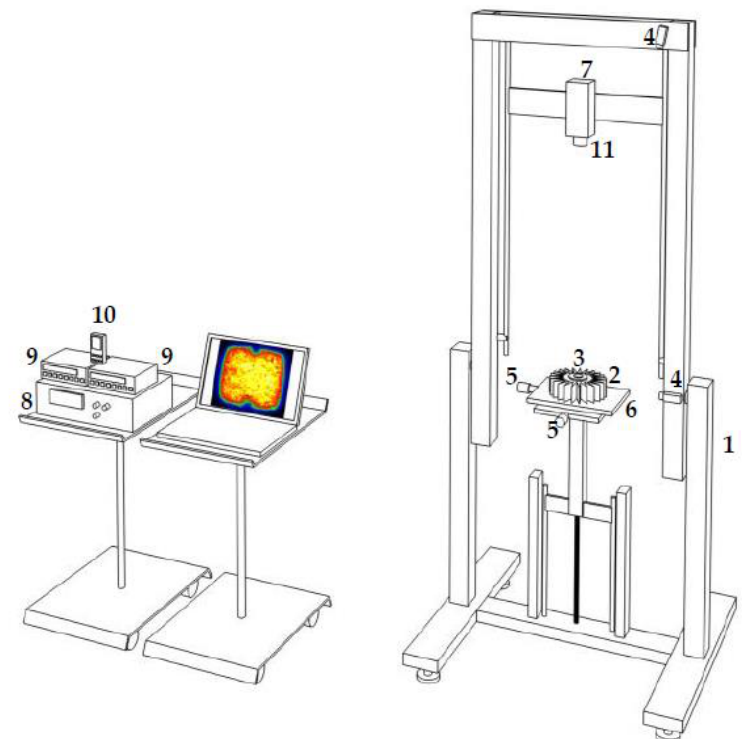
Figure 4. The set-up for precise luminance measurements (measurements up to 1 m), where: 1 – goniophotometer, 2 - cooling system, 3 - tested high-power LEDs, 4 – laser, 5 - micrometre screw, 6 - measuring table, 7 - luminance meter, 8 - DC power supply, 9 - laboratory multimeter, 10 - tem- perature meter, 11 - lens.